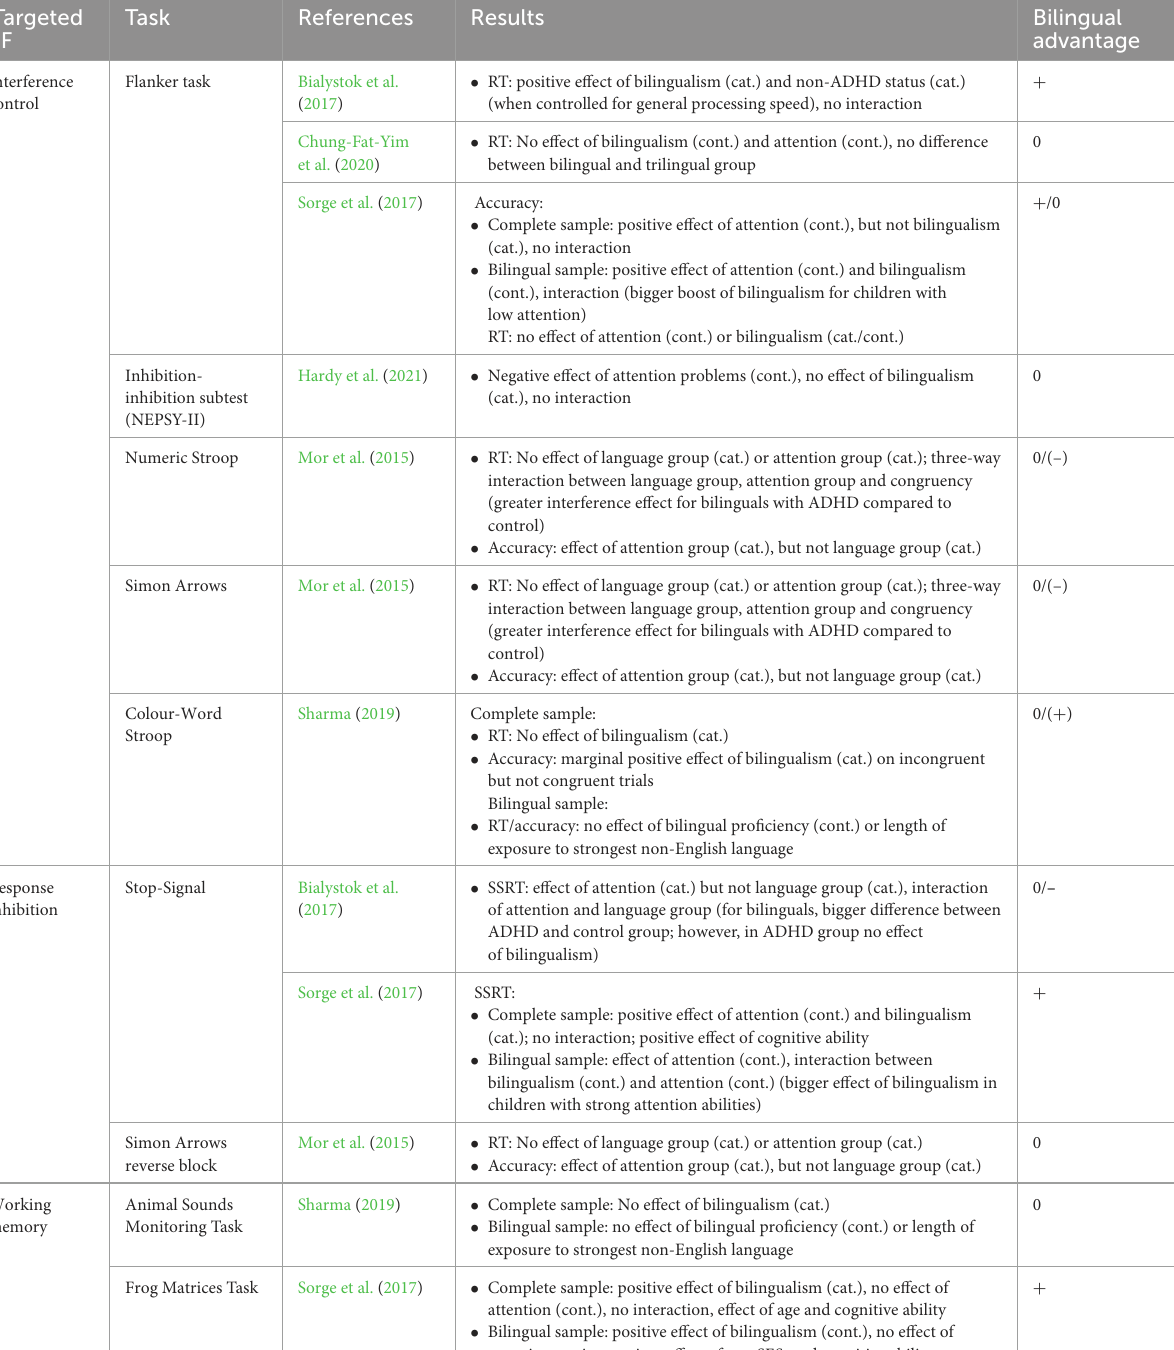
TABLE 2 Effect of bilingualism and attention ability/ADHD status on executive function performance. Targeted